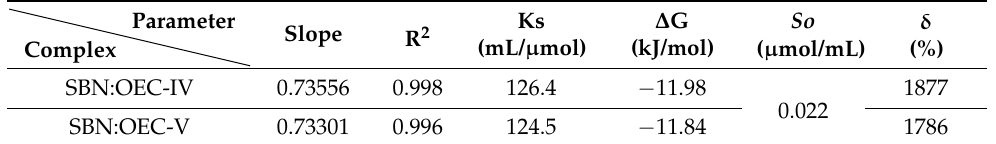
Table 2. Stability constants (Ks), thermodynamic parameter ( Δ G) and solubility enhancement factor ( δ ) derived from phase solubility diagrams. So —intrinsic solubility of SBN in the absence of complexing agents.